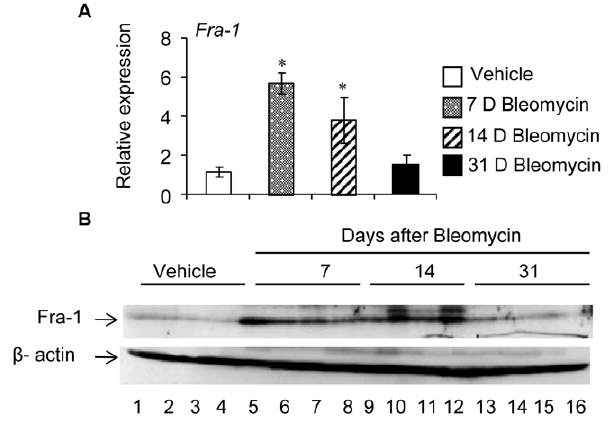
Figure 7. Bleomycin-induced Fra-1 expression in the lung. A: At indicated period of post-bleomycin instillation, lung tissues were harvested from wildtype mice and used for Fra-1 gene expression by real-time RT-PCR (n=4 2 6). B: Fra-1 expression was analyzed